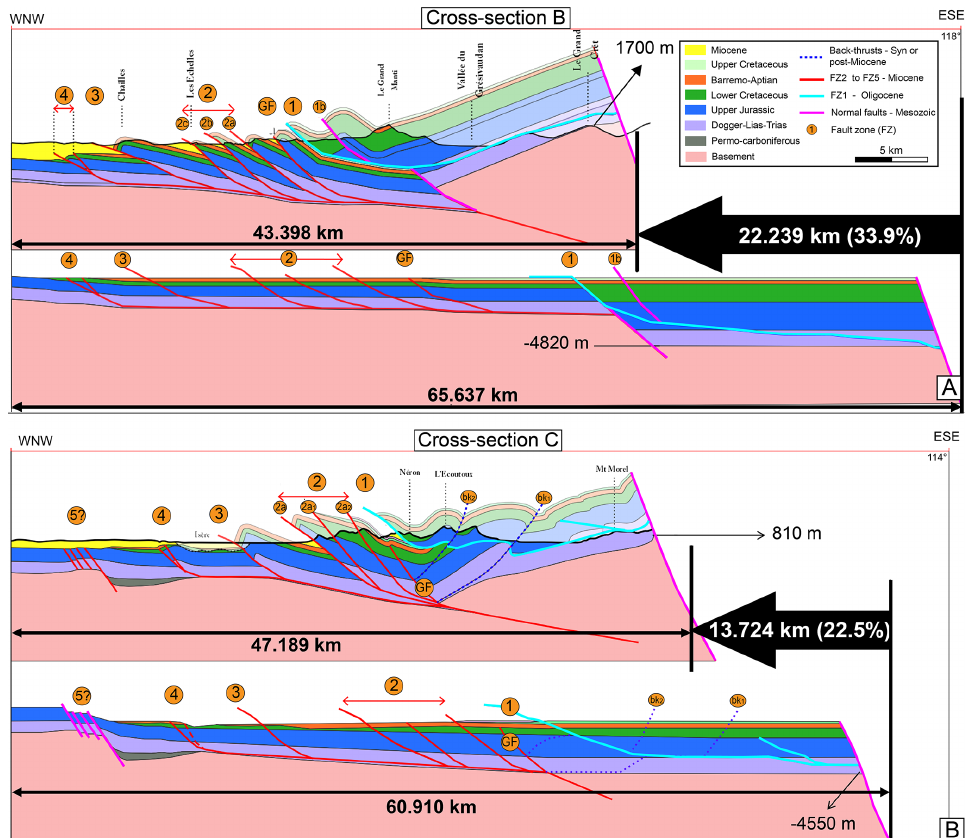
Figure 18. Balanced cross sections throughout the Chartreuse massif using the MOVE software, assuming that ZF2 to ZF4 are rooted below a single Belledonne basal thrust. (A) Cross section B (Fig. 11B). (B) Cross section C (Fig. 11C). See Fig. 1B for locations. Note that the backthrusts visible in the east of section C (bk1 and bk2, Fig. 11C and panel B of this figure) are interpreted as related to a late tectonic phase; see text for details. Corresponding shortening amounts and rates are listed in Table